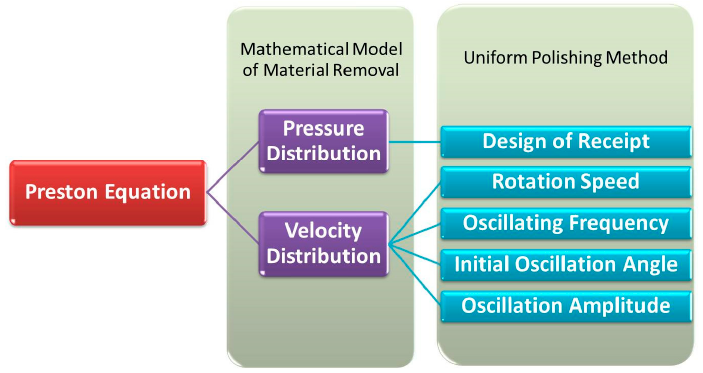
Figure 2. Framework of this paper.